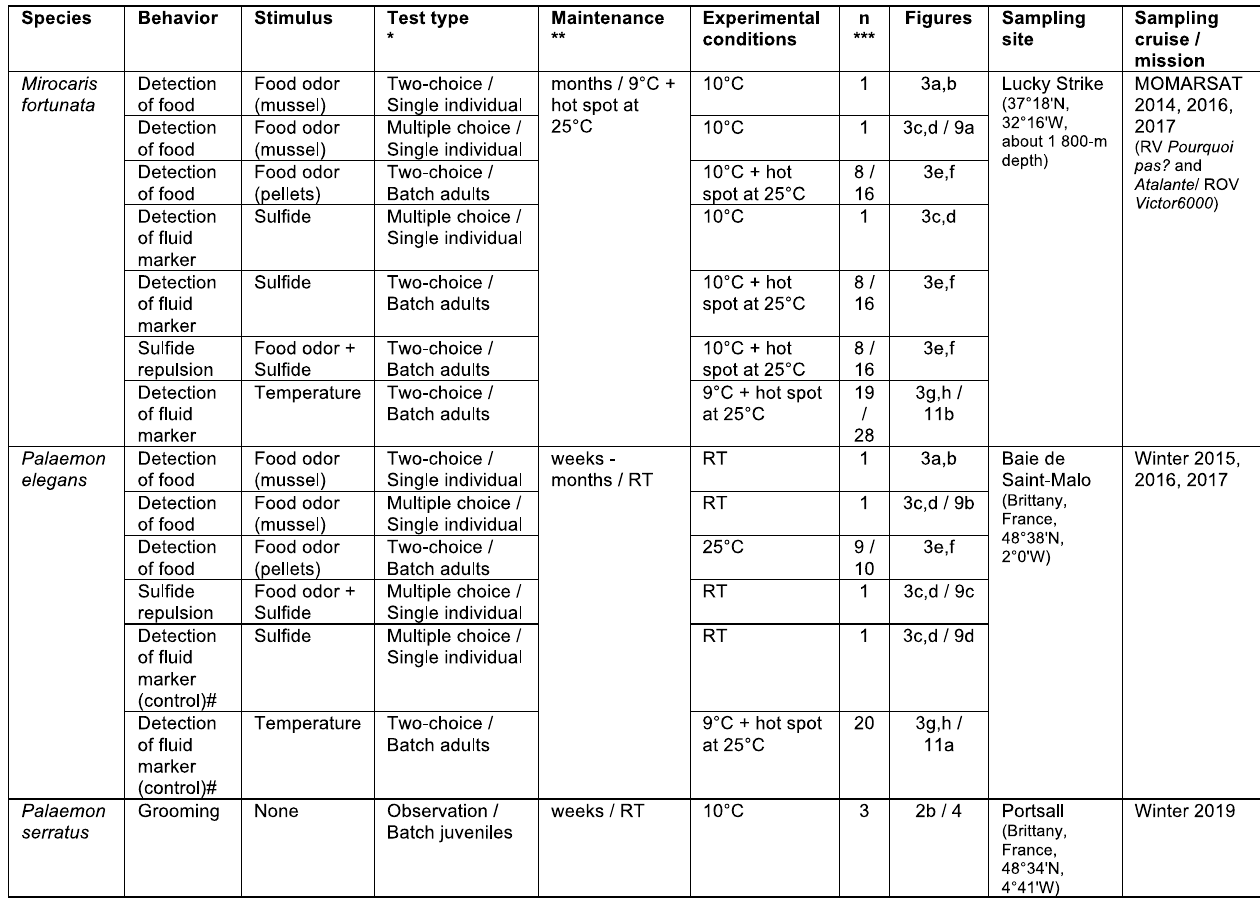
Figure 3. Species collection and experimental condition for behavioral experiments at atmospheric pressure. * Type of test applied either to a batch of shrimp or to single specimens; ** duration and condition of maintenance at atmospheric pressure before the experiment; *** number of shrimp for each experiment (some experiments were performed several times, see figure legends for more information); # experiments with sulfide and temperature were carried out for comparison with hydrothermal species.